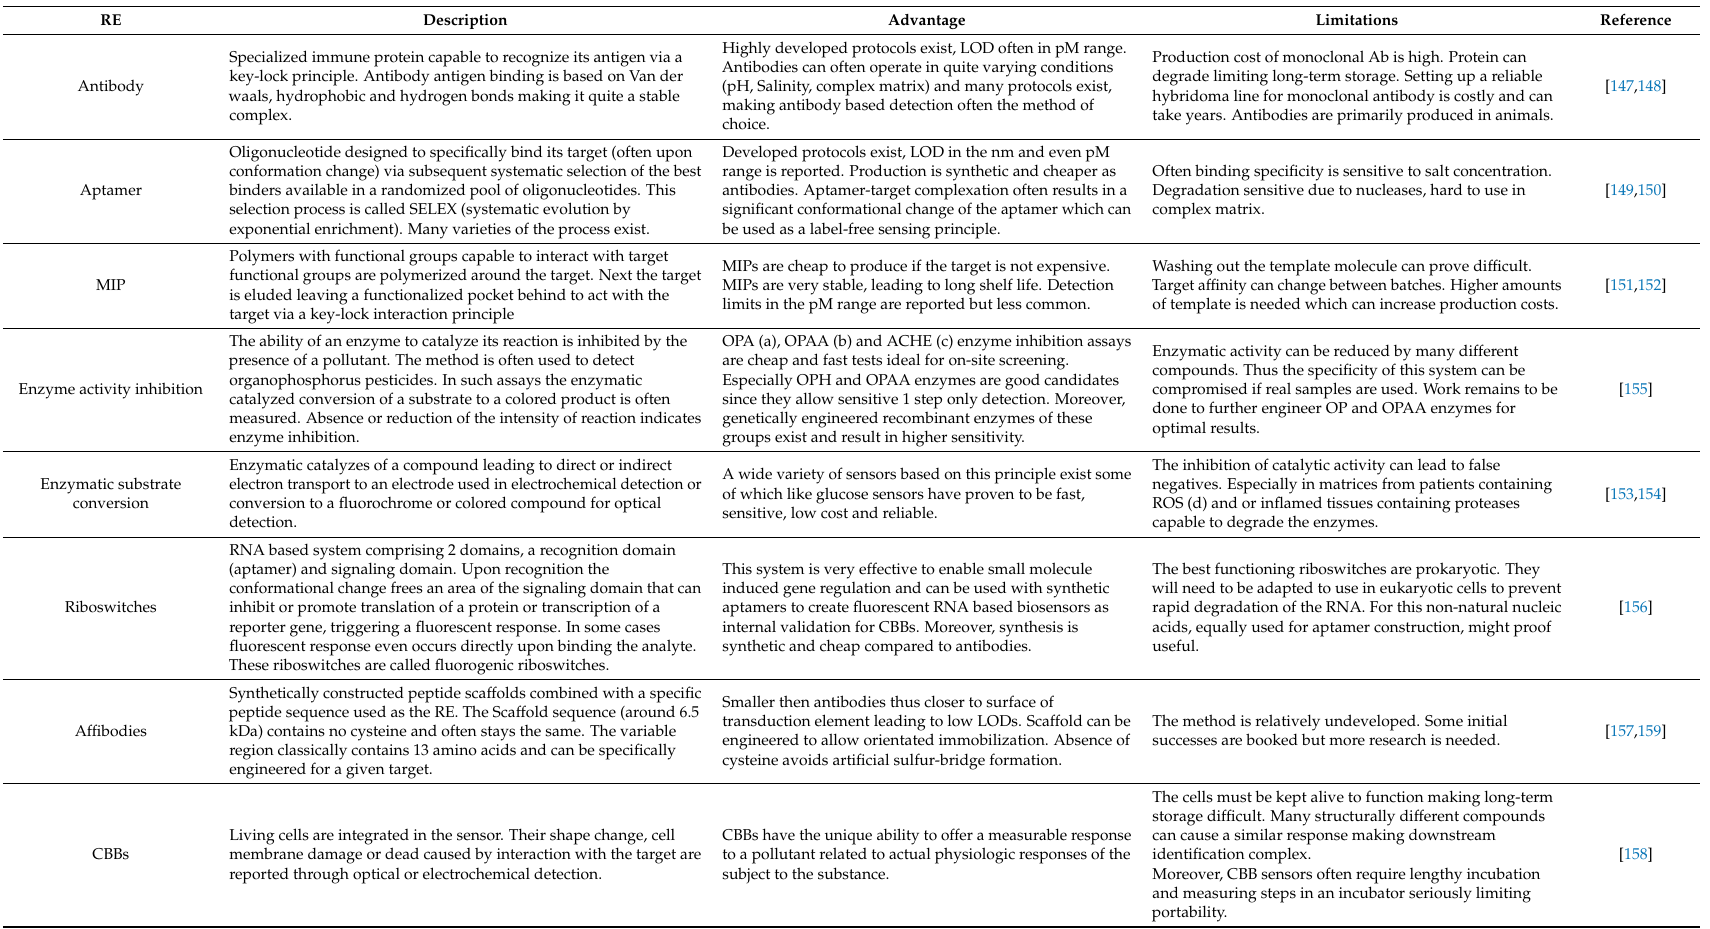
Table 3. A description of REs which illustrates the advantages and limitations of